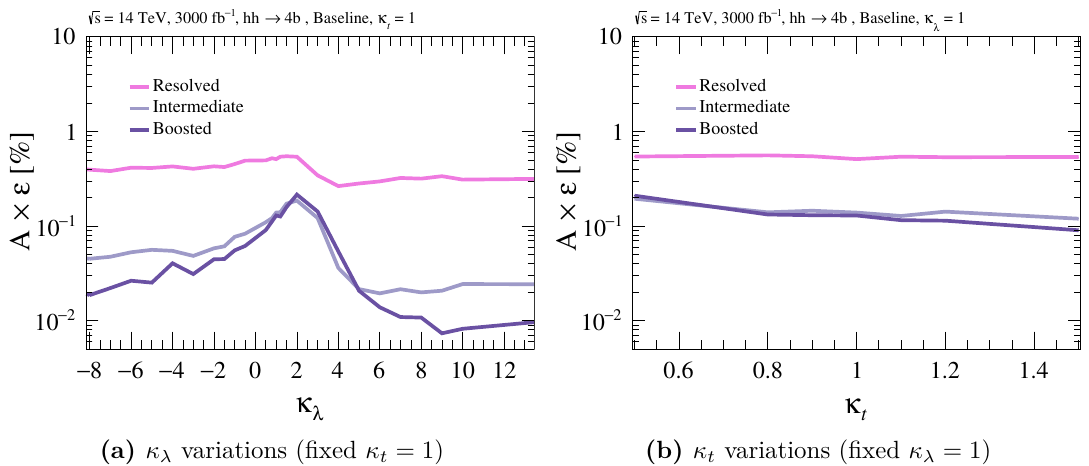
Figure 6. Signal acceptance times efficiency A × ε in percent for the baseline analysis for variations in (a) κ λ and (b) κ t . This is shown for the resolved (pink), intermediate (lilac) and boosted (purple) categories. The A × ε is equivalent to the number of signal events S divided by initial number of events σ × L